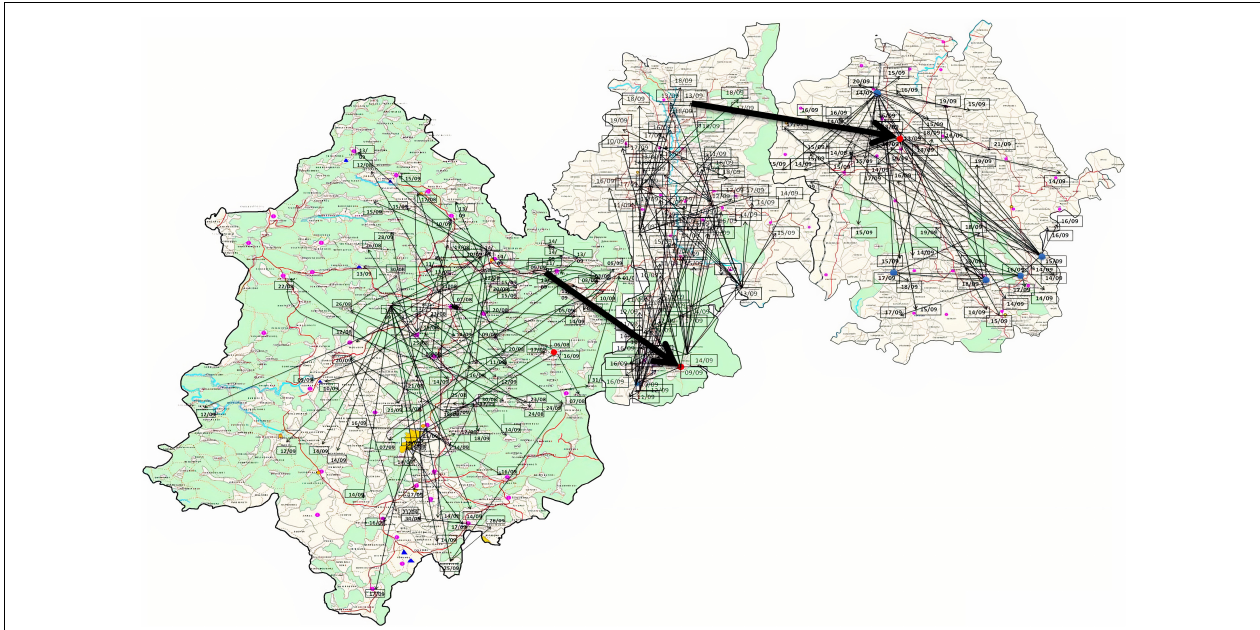
FIGURE 5 | Spread of V. cholerae O1 biotype El Tor in three blocks of Rayagada district (Kashipur, Kalyansinghpur, and Bissam Cuttack): August–September,